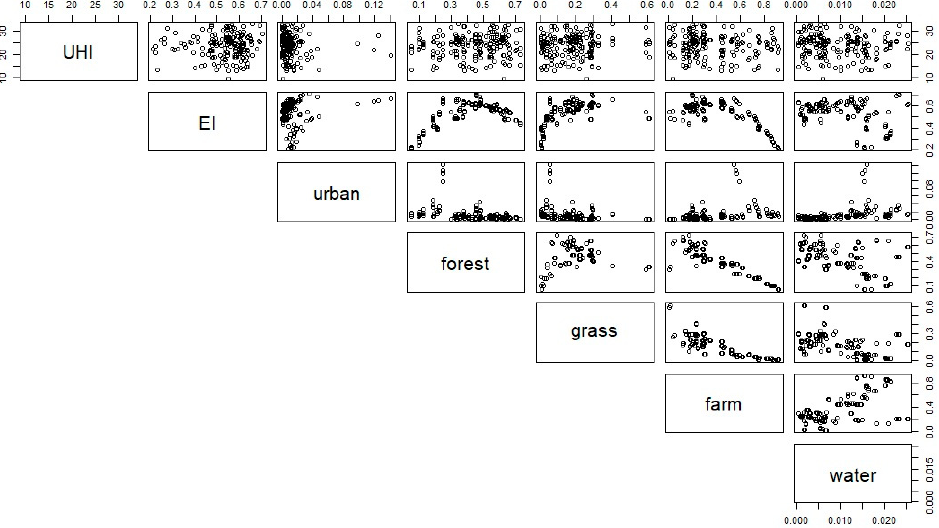
Figure 4. Scatterplots between UHI and land cover.